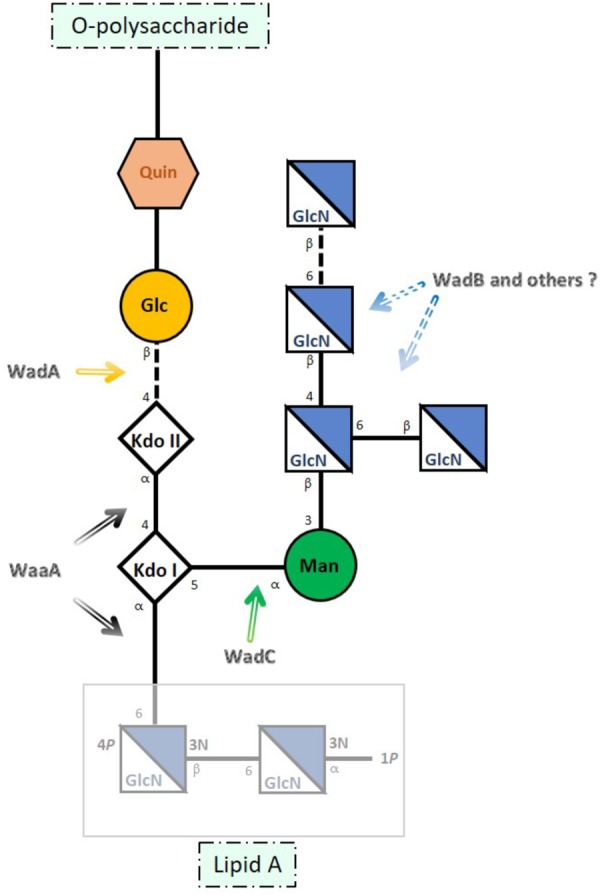
Schematic representation of Brucella melitensis LPS core. The site of action of the glycosyltransferases identified thus far is indicated with arrows. Kdo (3-deoxy-D-manno-octulosonic acid), Glc (glucose), Man (mannose), GlcN (glucosamine), and Quin (quinovosamine) [adapted from Fontana et al. (2016) and Gil-Ramírez et al. (2014)].